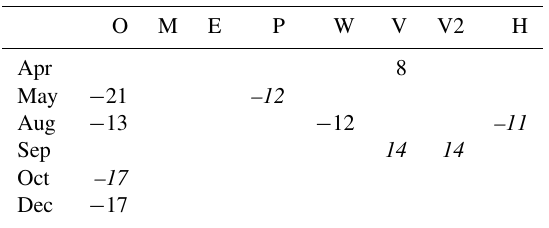
Table 8. Linear, decadal changes in monthly mean LW ↓ (Wm − 2 ) at Bergen between January 1985 and December 1999 significant at a 5% or 10% (denoted in italics) level.